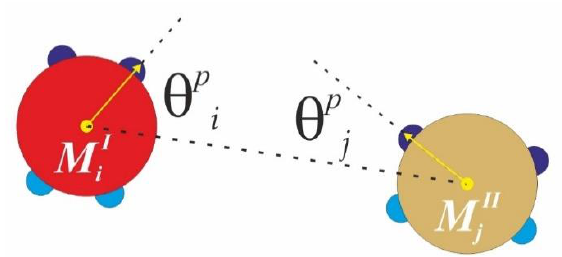
Figure 4. Minimal patchy angle between SN patches for monomer of type I ( M i ) and for monomer type II ( M j ). These angles are used to evaluate the modulated LJ interaction potential between the monomers.